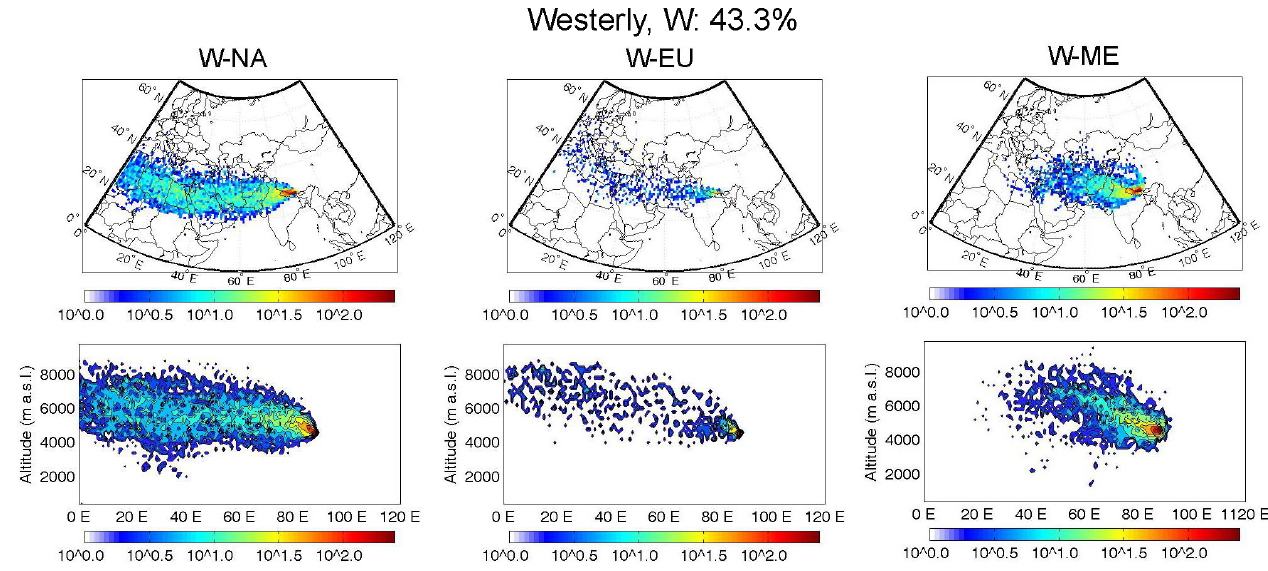
Fig. 5a. Westerly “W” clusters of night-time 3-D back-trajectories at NCO-P for the period March 2006–18 February 2008 (vertical cross section included). The frequency of cluster occurrence is reported in the Fig.